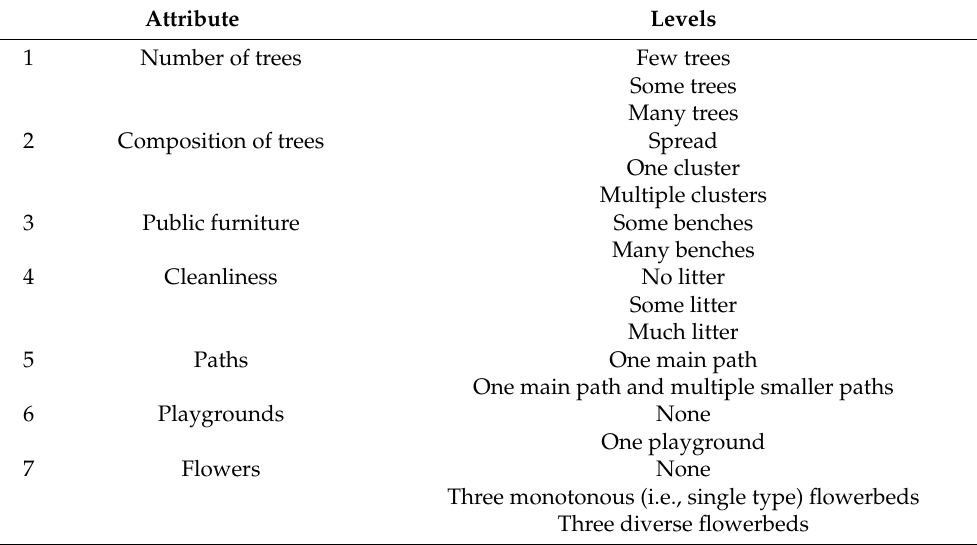
Table 1. Selected attributes and their